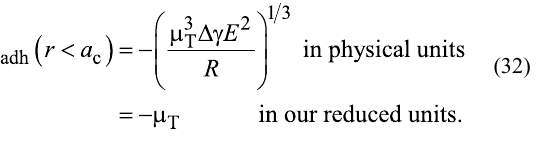
which becomes p adh ( r < a c ) = −Δγ / z 0 within the true contact area. Using Equation 19, one obtains